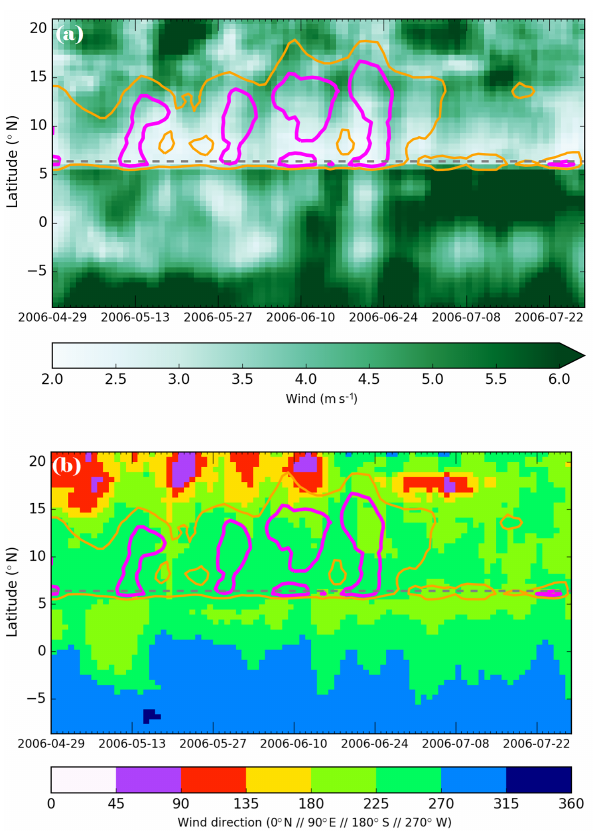
Figure 6. Time–latitude average (Hovmöller diagram) of surface wind: (a) speed and (b) direction, along a meridional transect from 2 to 19 ◦ N and averaged from 2 to 3 ◦ E including Cotonou (Benin) and Niamey (Niger). Wind directions are presented with steps of 45 ◦ . Day-to-day variability is smoothed by applying a moving av- erage of ± 2 days. Orange and violet contours are surface PM 2 . 5 concentrations of 4 and 5µgm − 3